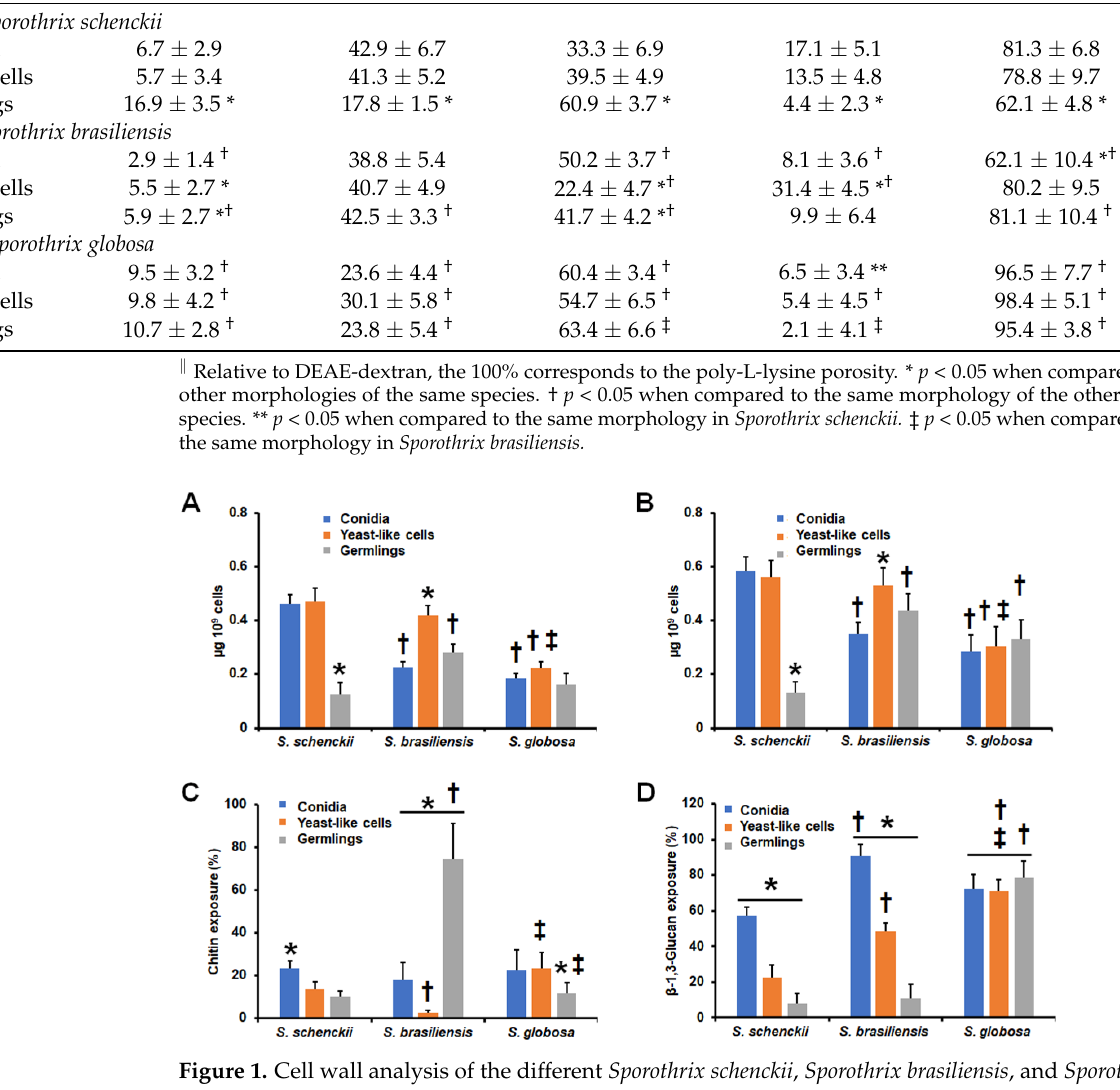
Table 1. Cell wall composition and porosity of conidia, yeast-like cells, and germlings from Sporothrix schenckii , Sporothrix brasiliensis , and Sporothrix globosa . Cell Wall Abundance Organism